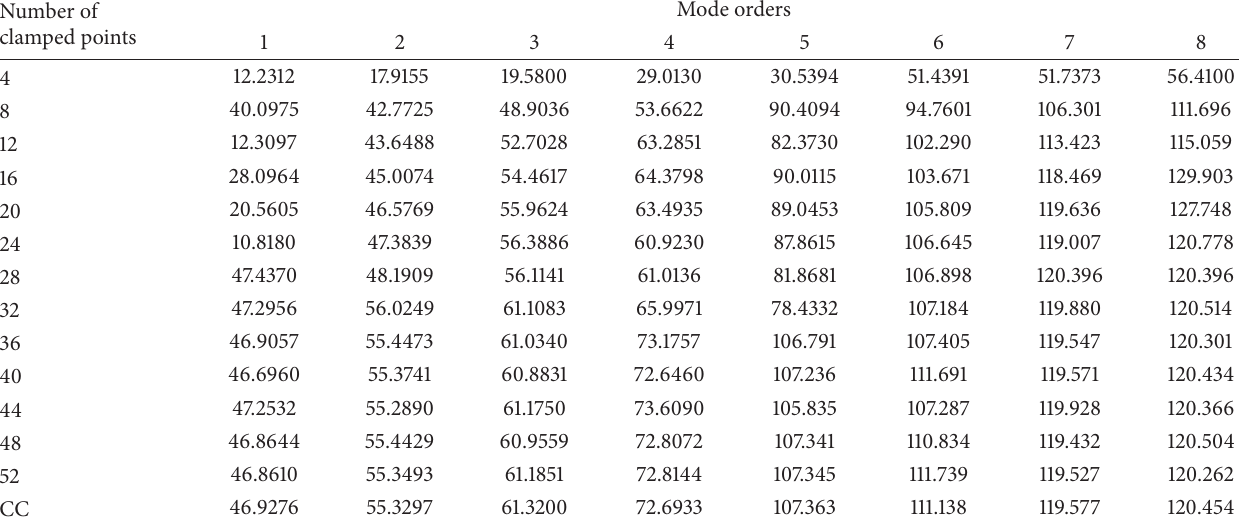
Table 14: First eight frequencies (Hz) for an open spherical shell with multipoints clamped-supported on the two edges 𝛼 = 0 and 𝛼 = 𝐿 𝛼 . Number of clamped points